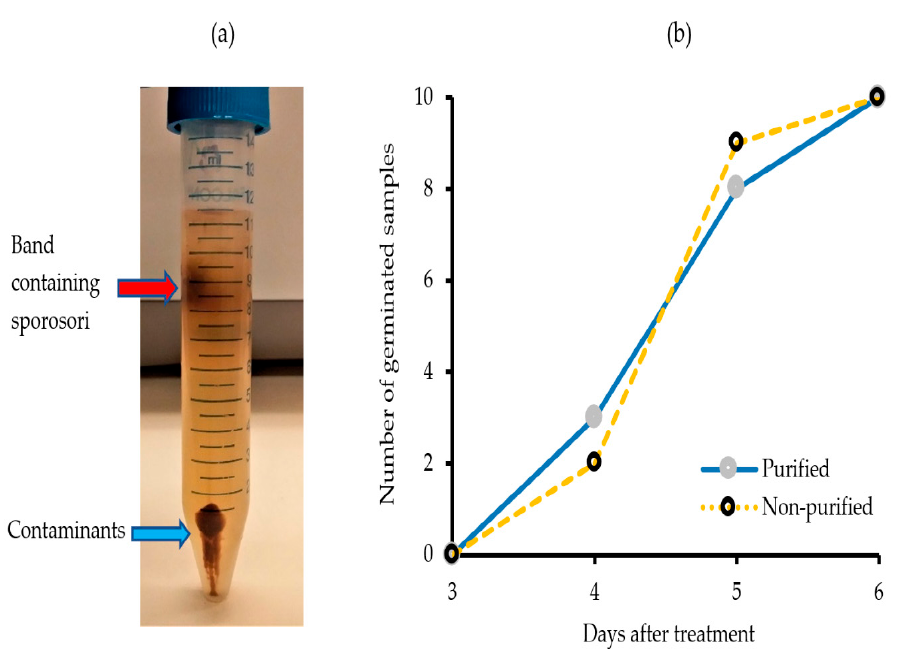
Figure 1. ( a ) Band of resting spores in the Ludox ® gradient and ( b ) the cumulative curve of purified and non-purified S. subterranea resting on the spore’s germination in the Hoagland’s